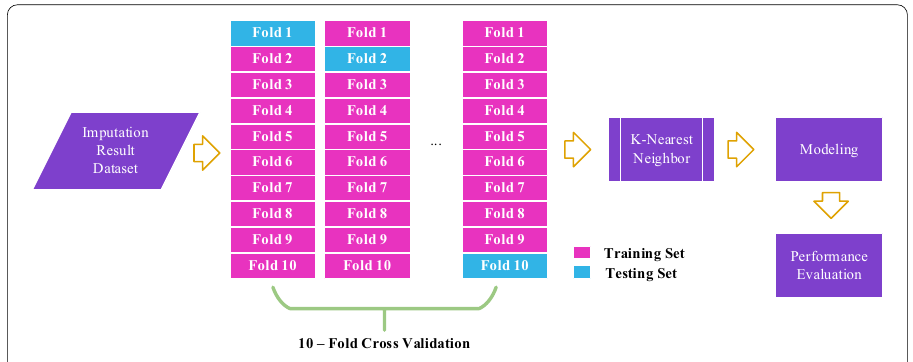
Fig. 5 Method of evaluation for getting AUC, AUC-PR, accuracy, F1-score, precision, and